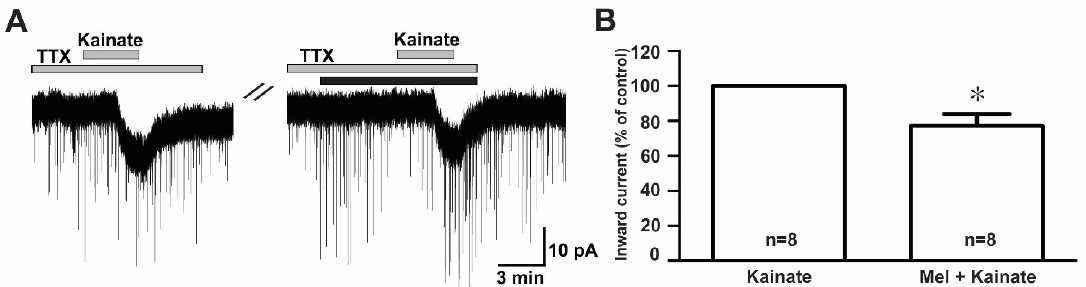
Figure 6. Direct melatonin action on the ionotropic glutamate receptor-mediated effect on GnRH neurons. ( A ) A representative current trace showing inhibition of the kainate (10 μM)-induced response by 10 μM melatonin in the presence of tetrodotoxin (TTX) (0.5 μM), a voltage-sensitive sodium channel blocker. The black bar represents the duration of the melatonin application. ( B ) Bar graph showing the mean relative percentage of inward currents induced by kainate in the presence of melatonin + TTX compared to kainate in the presence of TTX (* p < 0.05; paired t -test). n , the number of neurons tested.